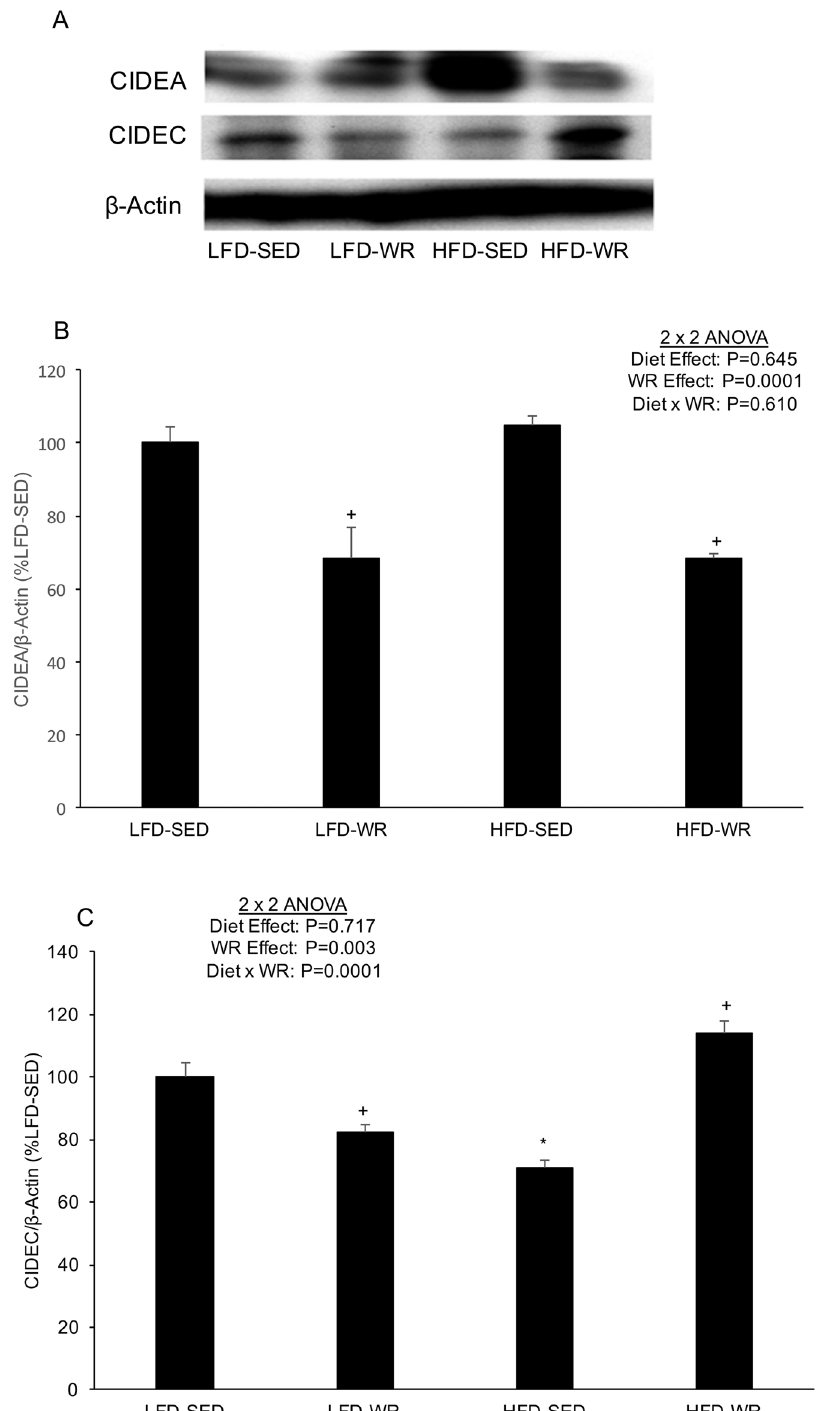
Fig 2. The effects of a high fat diet and voluntary wheel running on Cidea and Cidec protein expression in liver. Mice were fed a LFD or HFD and housed in standard cages or wheel running cages for weeks. Liver was excised and rapidly frozen in liquid nitrogen for subsequent Western blot analyses. (A) Representative immunoblots for Cidea and Cidec as well as β -actin as a loading control. Quantification of (B) Cidea and (C) Cidec protein, each normalized to β -actin. * , Denotes statistically significant difference from HFD-Vehicle. N = 5 mice per group.